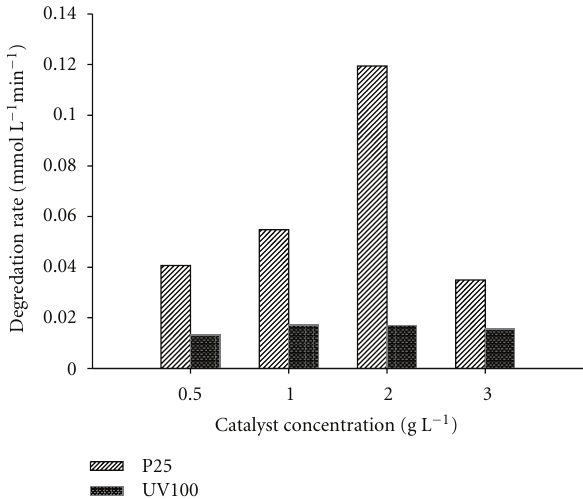
Figure 4: Influence of catalyst concentration on the degradation rate of Dinoseb. Experimental conditions: Photocatalysts TiO 2 Degussa P25 and Hombikat UV100 (0.5, 1, 2 and 3 gL − 1 ).